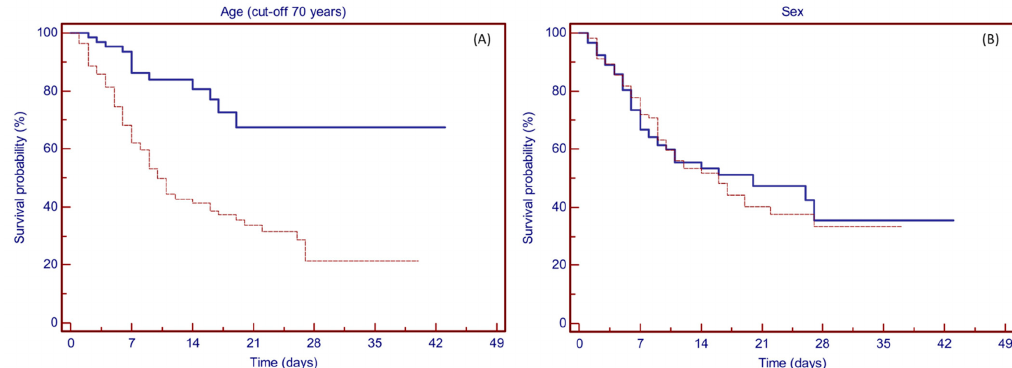
Figure 2. Kaplan–Meier plots showing the probability of survival based on patients’ characteristics. ( A ) Patients aged less than 70 years (solid line) or older than or equal to 70 years (dashed line). Age showed prognostic significance for survival at a cut-off point set at 70 years ( p < 0.0001), with an estimated 28-day survival rate of 67.4% and 21.4%, respectively. ( B ) Survival was not affected by gender (female, solid line; male, dashed line) ( p = 0.086). Vaccines 2021 , 9 , x